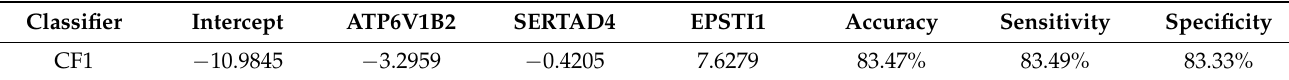
Table 5. Characteristics of the three-gene classifier using the NP/OP swab PCR-sample data GSE152075 (log(Raw + 1)) to classify COVID-19-confirmed and COVID-19-negative data into their respective